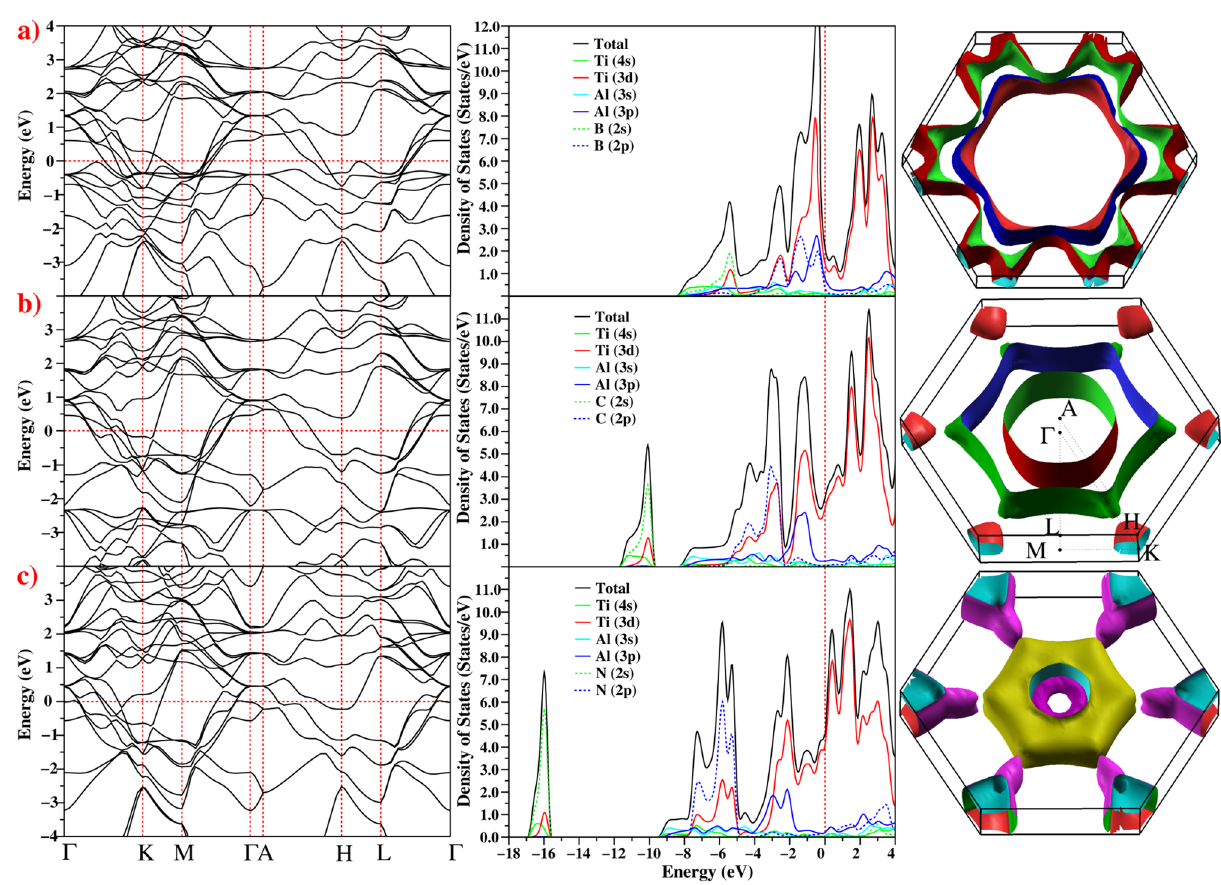
Figure 4. The electronic band structure, the total and partial electronic local density of states and Fermi surface for the hexagonal phase of ( a ) Ti 2 AlB, ( b ) Ti 2 AlC and ( c ) Ti 2